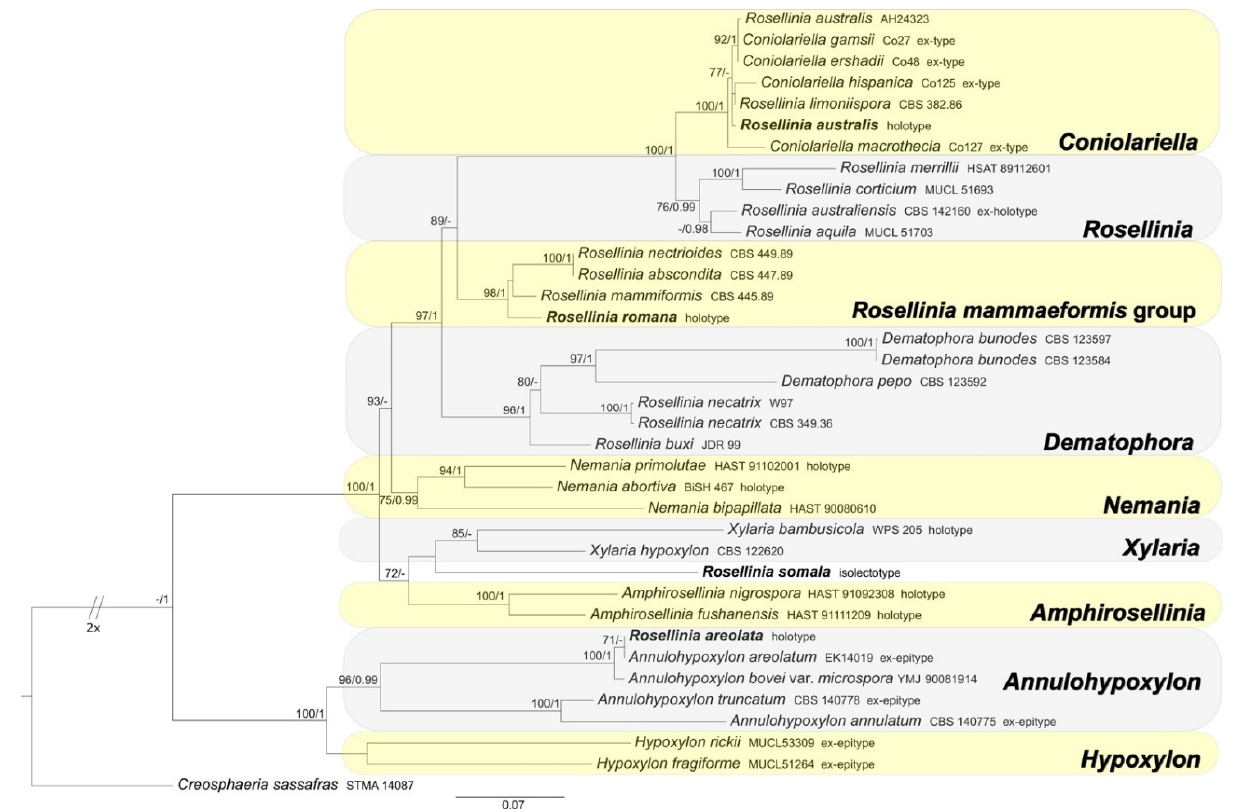
Figure 3. RAxML phylogram obtained from the combined ITS, LSU and TUB2 sequences of selected species belonging to genera of Xylariaceae and Hypoxylaceae. Creosphaeria sassafras (Lopadostomataceae) was selected as the outgroup taxon. MLB values ≥ 70% (left) and BPP values ≥ 0.95 (right) are shown on the branches. Newly obtained sequences are reported in bold .